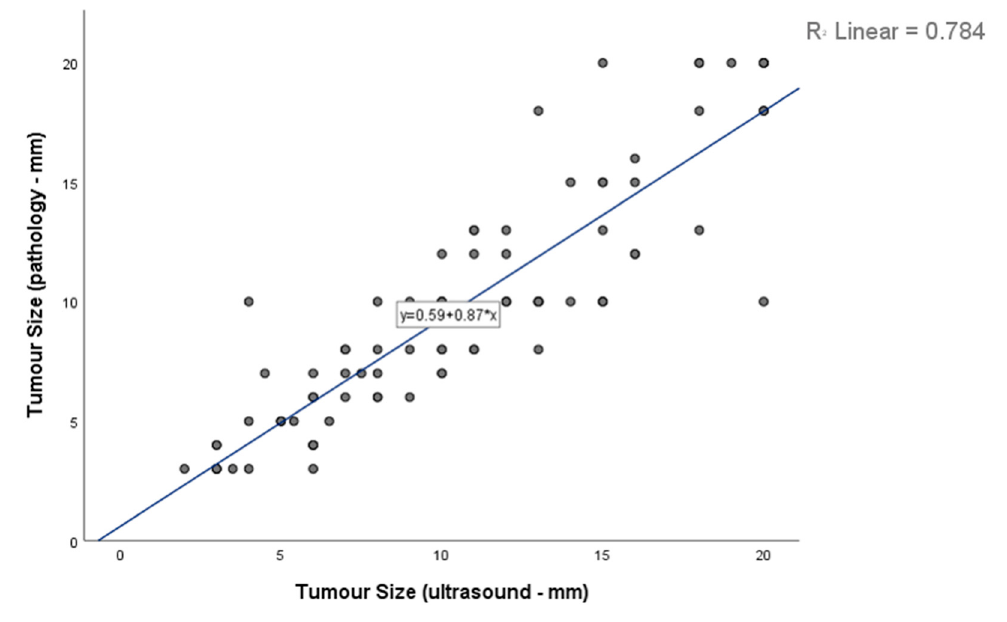
Figure 3. Linear regression of ultrasonographic lesion size plotted against histopathological lesion size, indicating that the former was a strong predictor of the latter ( p < 0.001).